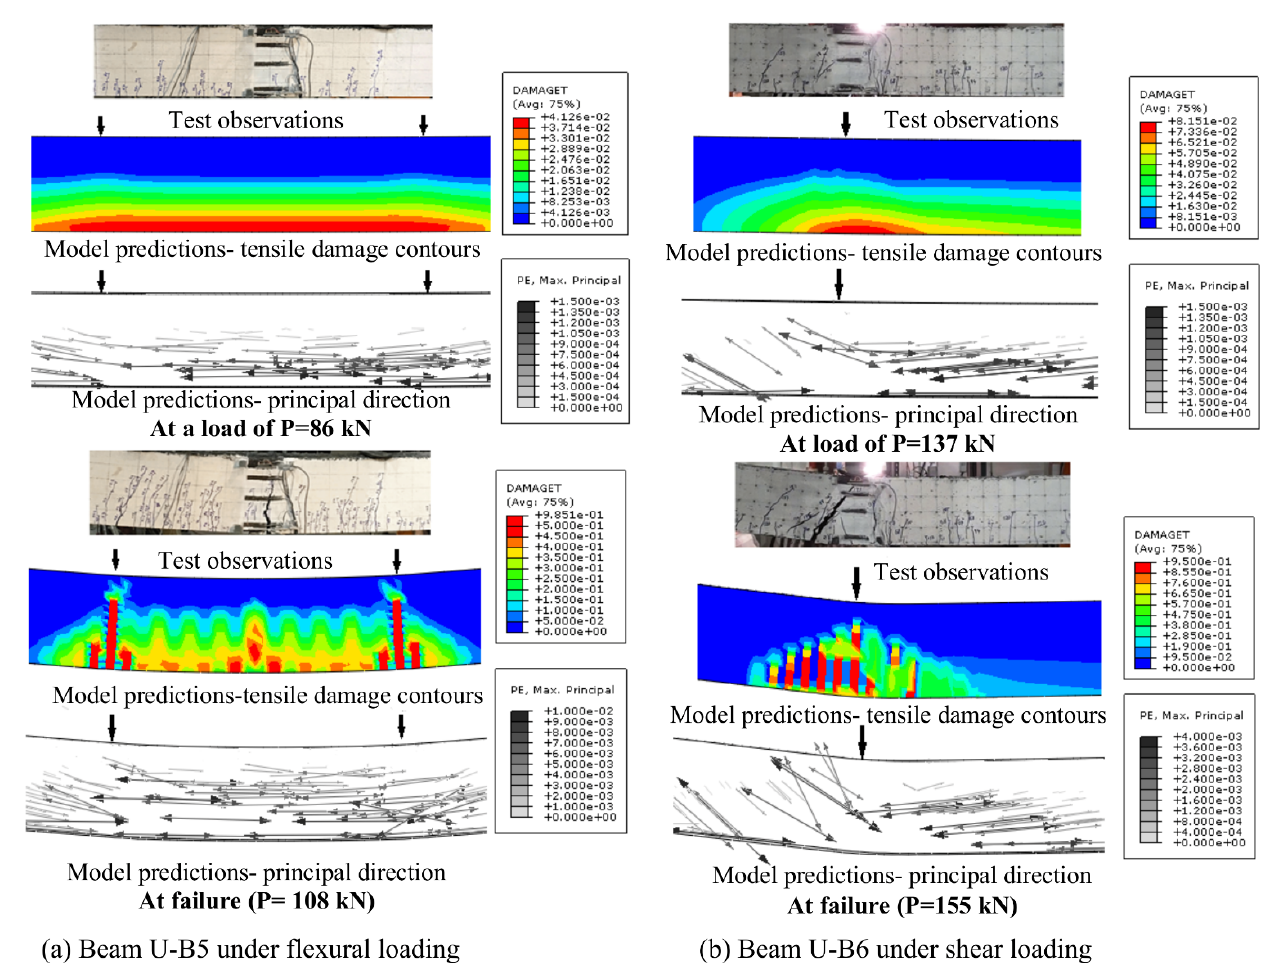
Figure 9. Comparison of tensile damage contours and principal strain direction as predicted by FEA with test data.